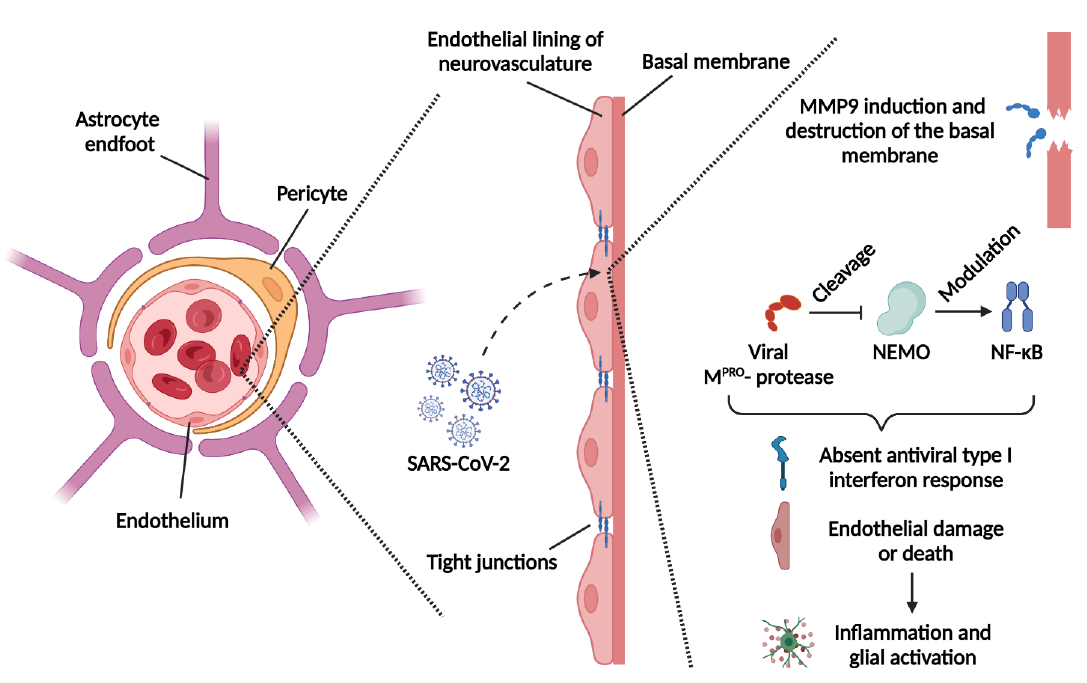
Figure 1. SARS-CoV-2 interactions with the blood–brain barrier: The blood–brain barrier is a semi- permeable barrier composed of microvascular endothelial cells, pericytes, and astrocyte end-feet. Tight junctions restrict paracellular passage of substances and pathogens. SARS-CoV-2 can pass via